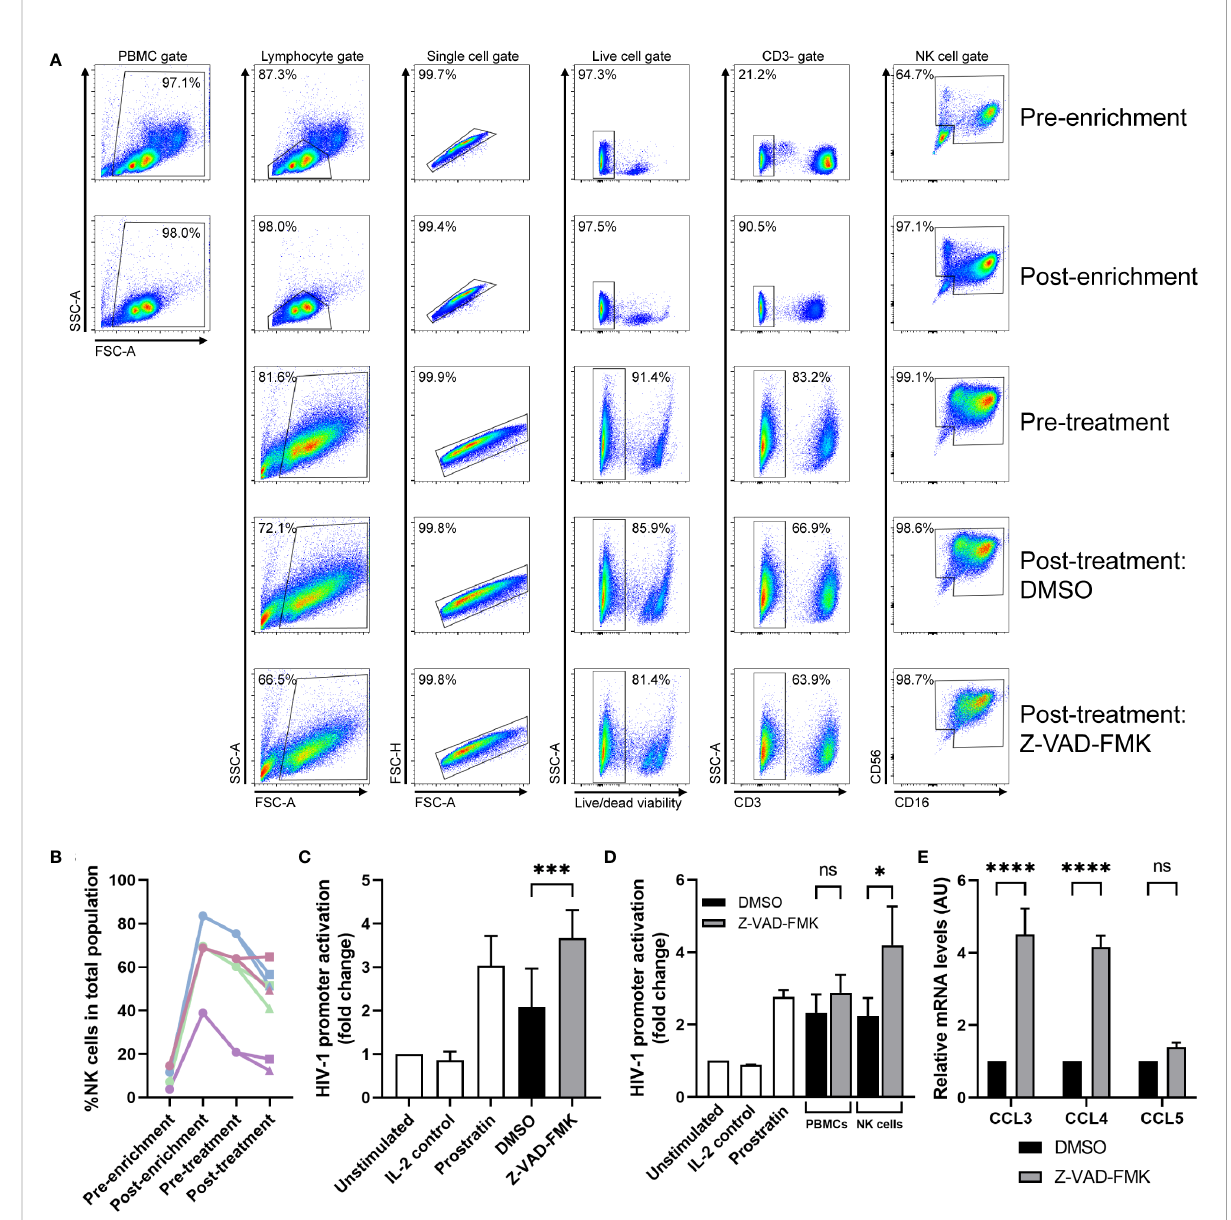
FIGURE 6 Primary NK cells can induce HIV-1 promoter activity after pan-caspase treatment. (A) Flow cytometry analysis on semi-enriched primary NK cells of one donor at different stages of the experiment; before semi-enrichment, after semi-enrichment, after 4 days of culture, and after 24 h treatment with DMSO or Z-VAD-FMK. (B) The percentage of all NK cells within the total cell population was plotted for each donor at each stage of the experiment. The values for post-treatment are divided between DMSO treatment ( ■ ) and Z-VAD-FMK treatment ( ▲ ). (C) Semi- enriched primary NK cells (from 8 donors) were cultured with Z-VAD-FMK or without (DMSO) for 24 h after which supernatants were used on reporter cells TZM-bl that were subjected to luciferase assay. (D) Semi-enriched primary NK cells (from 3 donors) or IL-2 activated whole PBMCs (from the same 3 donors) were cultured with Z-VAD-FMK or without (DMSO) for 24 h after which supernatants were used on reporter cells TZM-bl that were subjected to luciferase assay. (E) RNA was extracted from semi-enriched primary NK cells (4 donors) cultured with or without Z-VAD-FMK and mRNA expression of CCL3, CCL4, CCL5, and GAPDH (for normalization) was measured by qPCR. For all graphs, data points are plotted as mean ± SD. (ns, non-signi fi cant; *p < 0.05, ***p < 0.001, ****p < 0.0001;